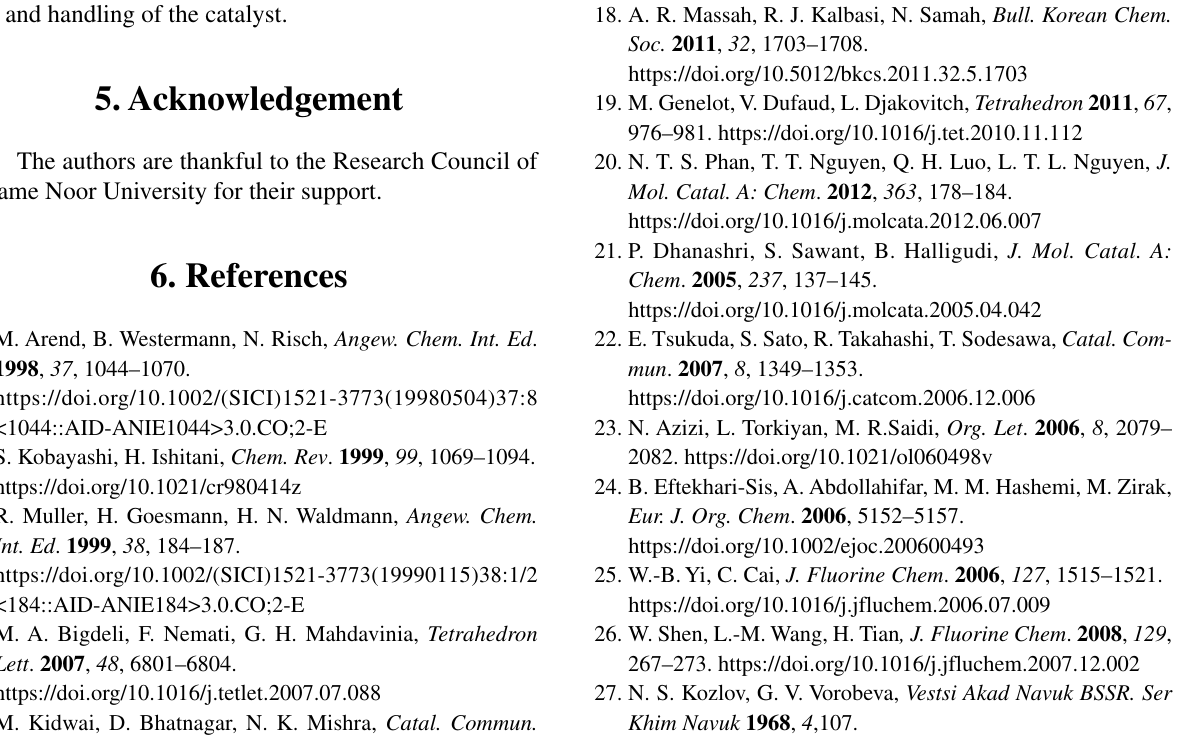
2-CH), 2.81–2.85 (m, 1H, 6-CH), 4.62 (d, J = 4.75 Hz, 0.58H, 8-CH), 4.79 (d, J = 3.5 Hz, 0.42H, 8-CH), 6.41 (d, J = 8.75 Hz, 2H, 12,16-CH Ar), 7.02 (d, J = 8.75 Hz, 2H, 13,15-CH Ar), 7.53 (dd, J = 8.75 Hz, J = 3.5 Hz, 2H, 1 2 18.22-CH Ar), 8.15 (d, J = 8.75 Hz, 2H, 19,21-CH Ar) ppm. Anal. Calcd for C H ClN O : C, 63.60; H, 5.34; N, 19 19 2 3 7.81. Found: C, 63.98; H, 5.84; N, 7.54. 2-(( p -Toluidino)(4-nitrophenyl)methyl)cyclohexanone (Table 2, 4p ): Yield: 71%, Yellow solid, syn / anti : 37/63, FT-IR: ν (KBr): 3367 (NH stretch), 1697 (C=O stretch) max cm –1 ; 1 H NMR (CDCl ): 1.59–1.92 (m, 3H, CH ), 3 2 1.94–2.05 (m, 3H, CH ), 2.17 (s, 3H, CH ), 2.26 (m, 2H, 2 3 2-CH), 2.81–2.85 (m, 1H, 6-CH), 4.68 (d, J = 5.25 Hz, 0.63H, 8-CH), 4.82 (d, J = 4.25 Hz, 0.37H, 8-CH), 6.41 (d, J = 8.25 Hz, 2H, 12,16-CH Ar), 6.89 (d, J = 8.25 Hz, 2H, 13,15-CH Ar), 7.55 (d, J = 8.75 Hz, J = 4.75 Hz, 2H, 1 2 18,22-CH Ar), 8.14 (d, J = 8.75 Hz, 2H, 19,21-CH Ar) H N O : C, 70.99; H, 6.55; N, ppm. Anal. Calcd for C 20 22 2 3 8.28. Found: C, 71.34; H, 6.81; N,